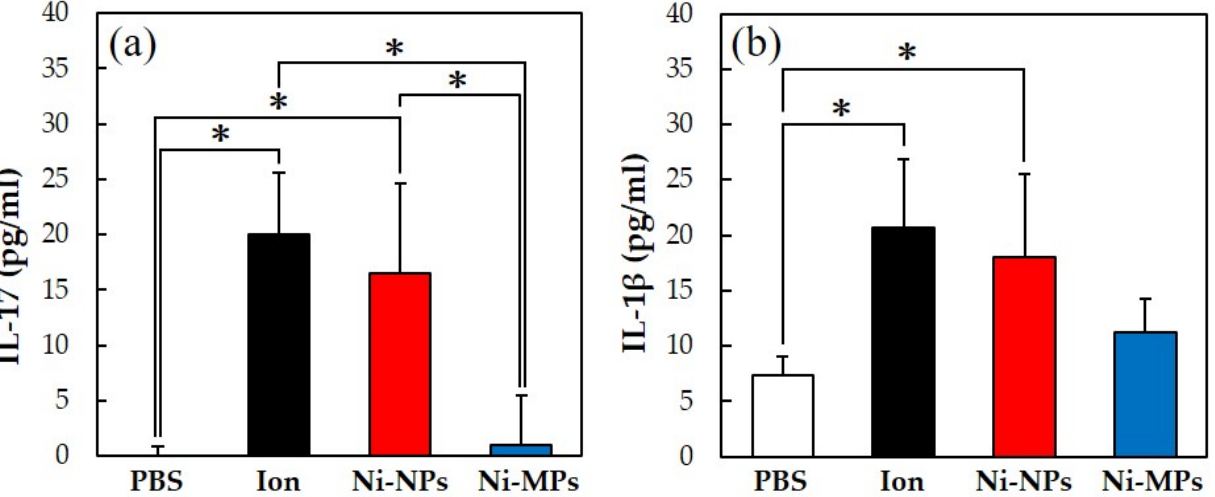
Figure 6. Comparison of serum cytokine levels after repeated oral administration test. ( a ) IL-17, ( b ) IL-1 β . Data are presented as the mean ± S.D., * denotes statistical significance p < 0.05.